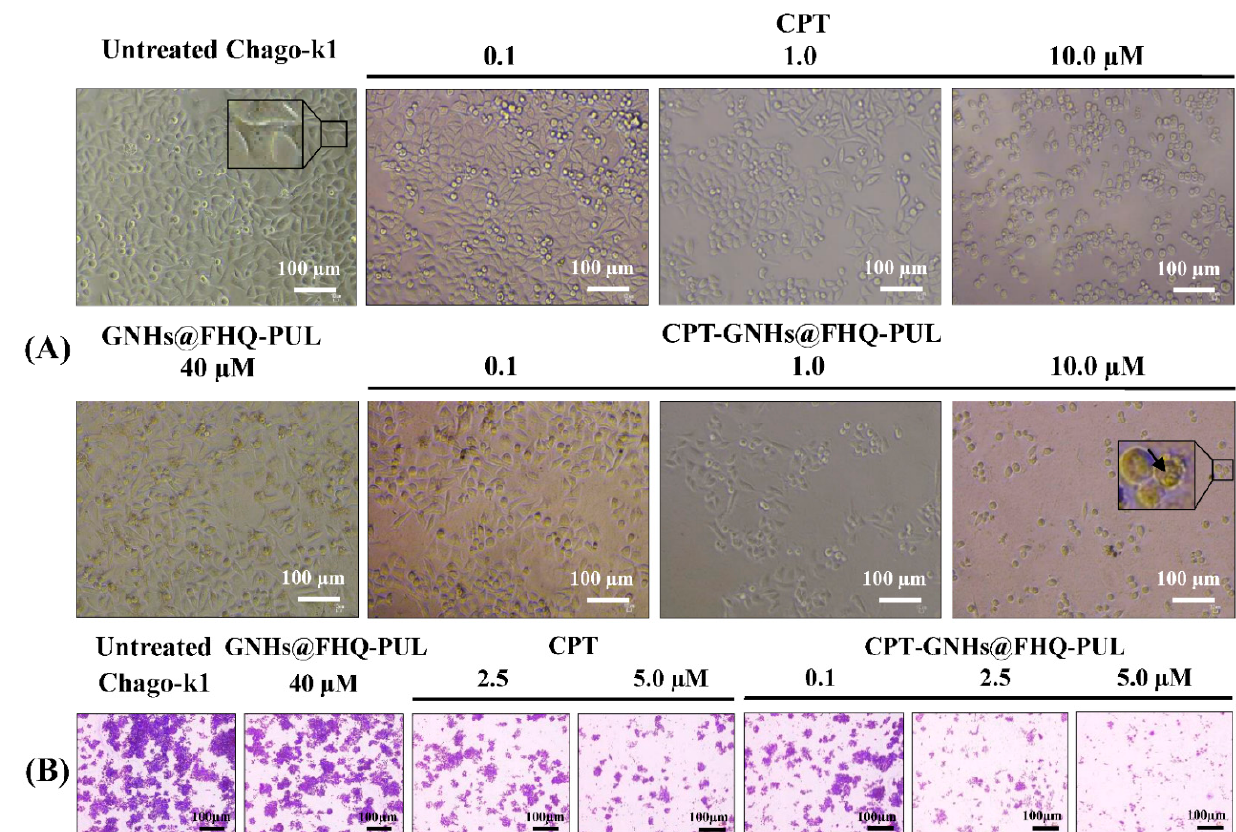
Figure 5. ( A ) Cell morphology and ( B ) colony formation assay of Chago-k1 cells after treatment with GNHs@FHQ-PUL, CPT, and CPT-GNHs@FHQ-PUL at 37 °C visualized under a phase-contrast microscope.